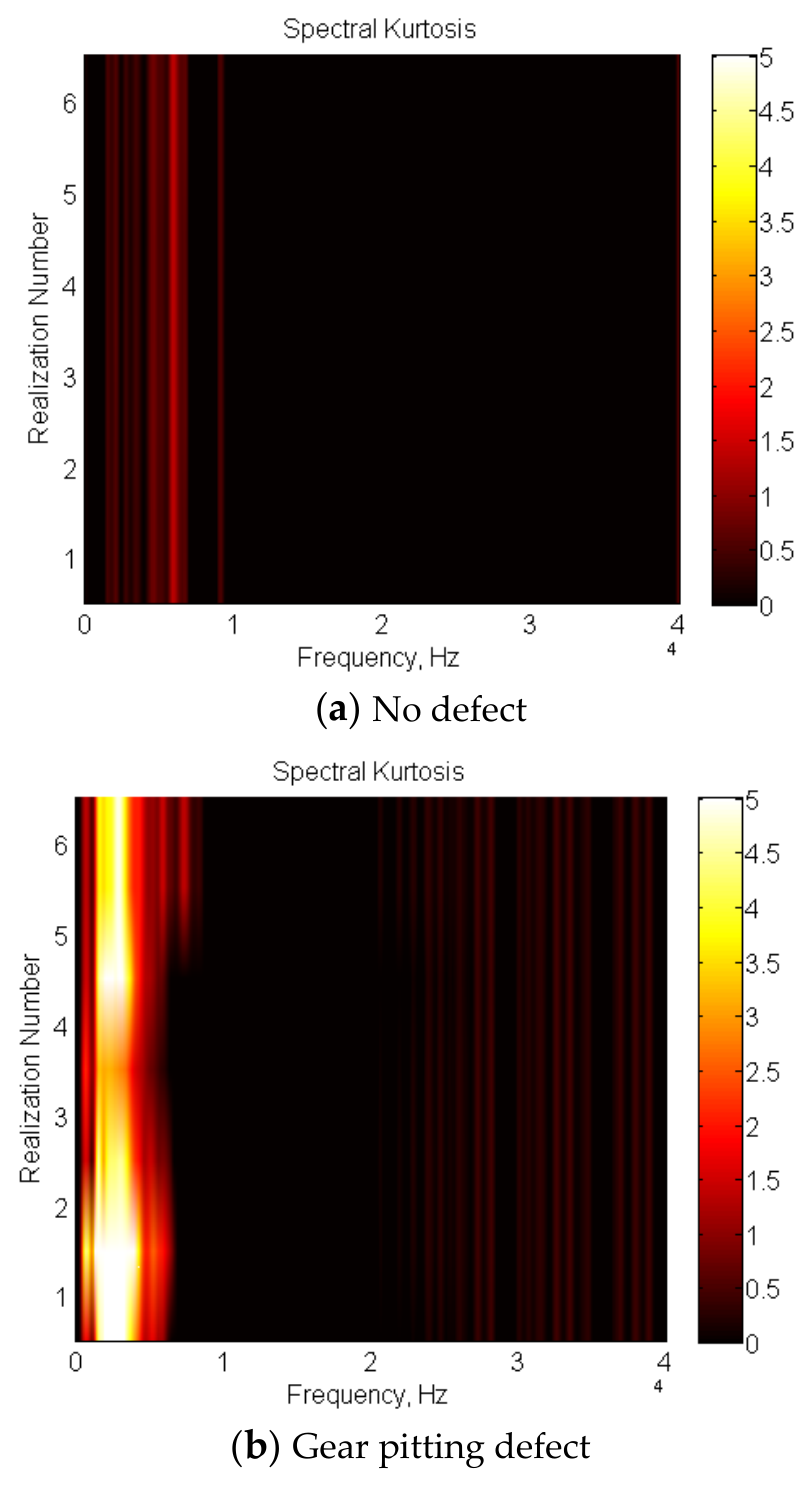
Figure 11. Spectral kurtosis for consequent gear vibration segments.